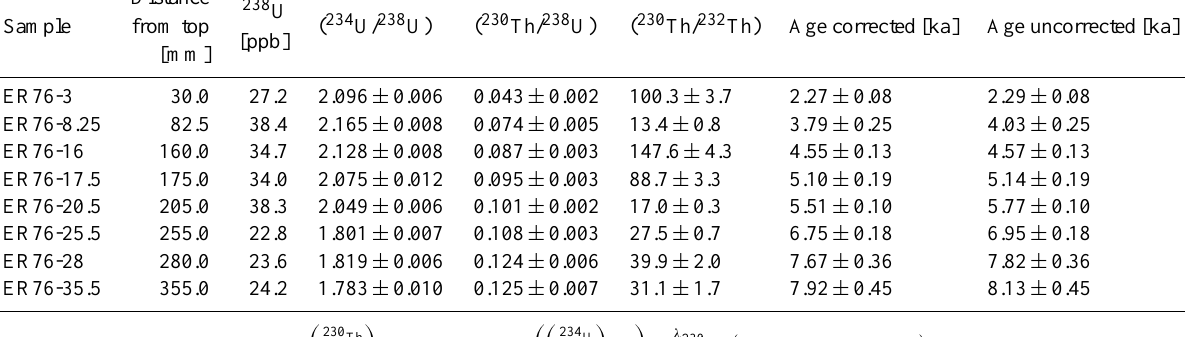
Table 1. Results of U-series dating. Distance 238 U Sample from top ( 234 U/ 238 U) ( 230 Th/ 238 U) ( 230 Th/ 232 Th) Age corrected [ka] Age uncorrected [ppb]